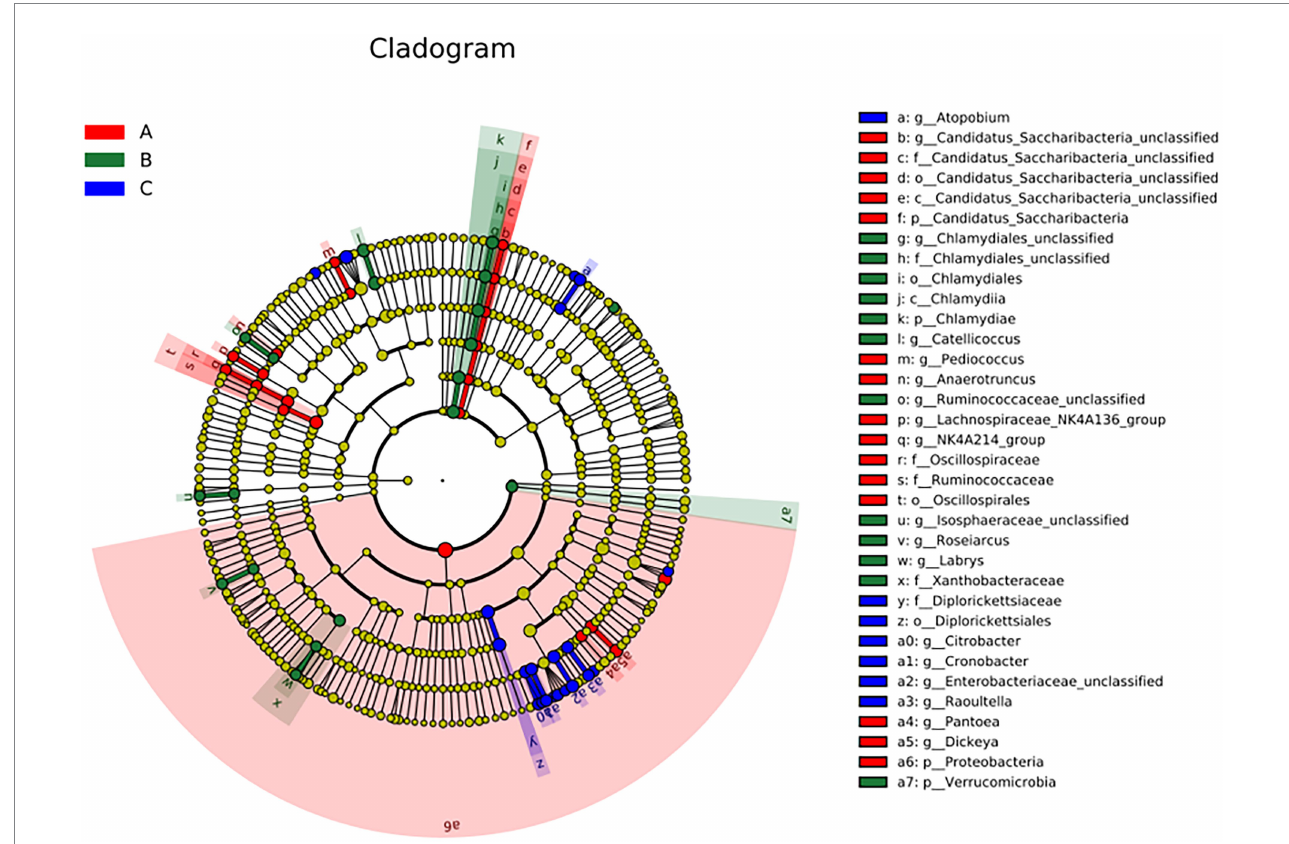
FIGURE 5 The linear discriminant fact size cluster trees of the three groups were used for 16S rRNA gene sequencing analysis. Distinct colors represent distinct groups; from the inside to the outside, the species level classification is shown: phylum, class, order, family, and